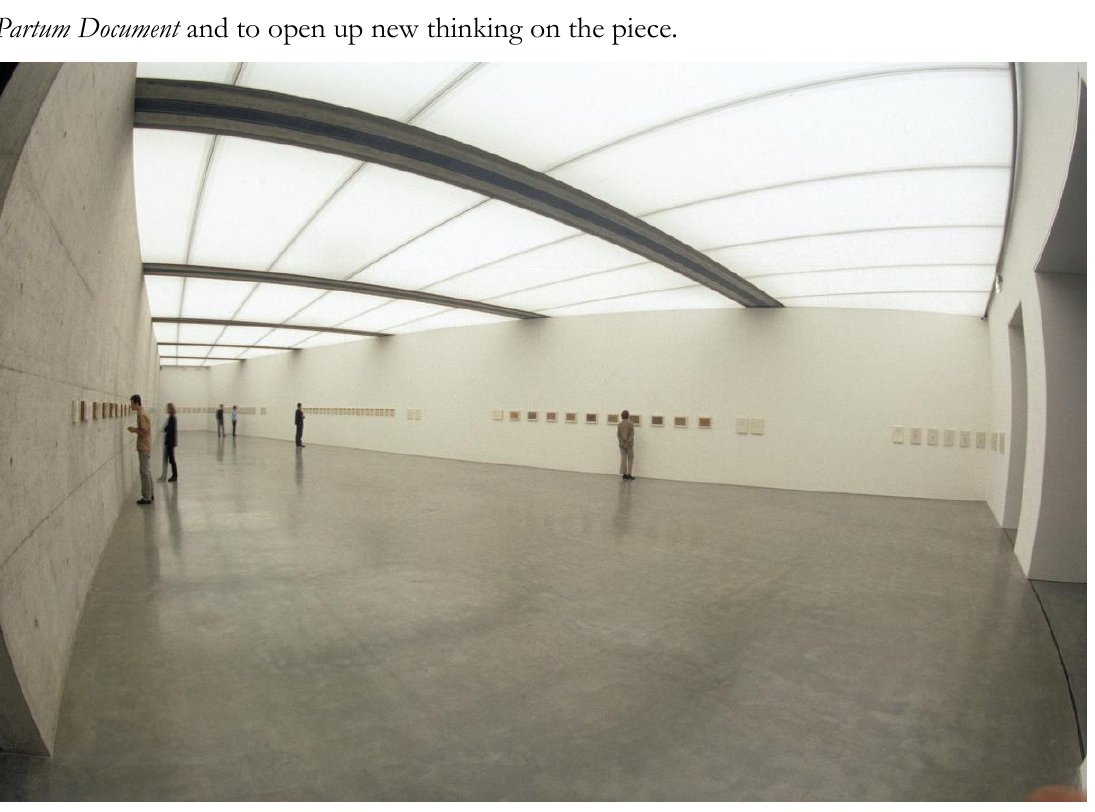
Figure 1: Mary Kelly Post-Partum Document, Installation, General Foundation, Vienna,